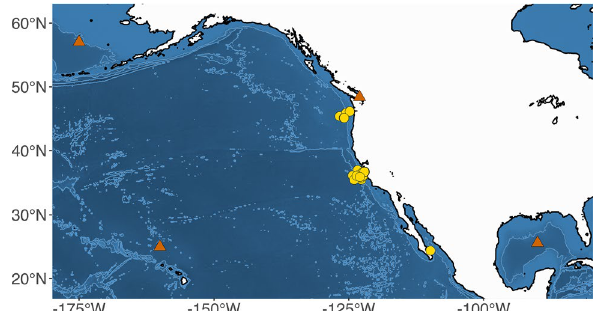
Figure 3. Geographic distribution H. moroteuthensis . Orange triangles indicate previously reported distribution in the Bering Sea, Gulf of Mexico and North Pacific Ocean near Washington and Hawai’i 29,30,40 . NB The latter locations are only indicators of reported observations and do not represent actual coordinates as these were not provided in the referenced literature. Yellow circles triangles represent in situ observations of H.